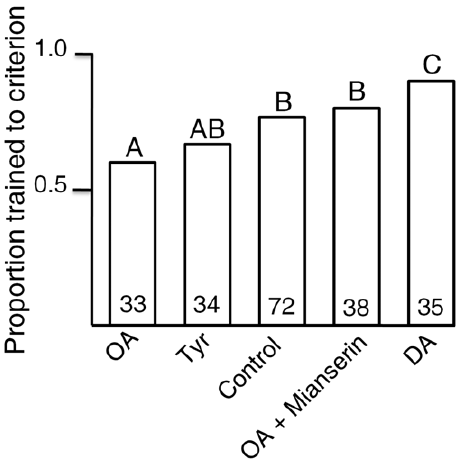
Figure 6. Training to criterion of complete avoidance. Propor- tion of bees trained to complete avoidance across treatment groups (control, OA, DA, TYR, and OA + Mianserin) differed significantly (Likelihood ratio test: X 2 =13.458, df=4, P , 0.01). The numbers in the bars indicate the number of individuals in each group. The bars with different letters are statistically significantly different (P , 0.05) from each other in multiple comparisons.